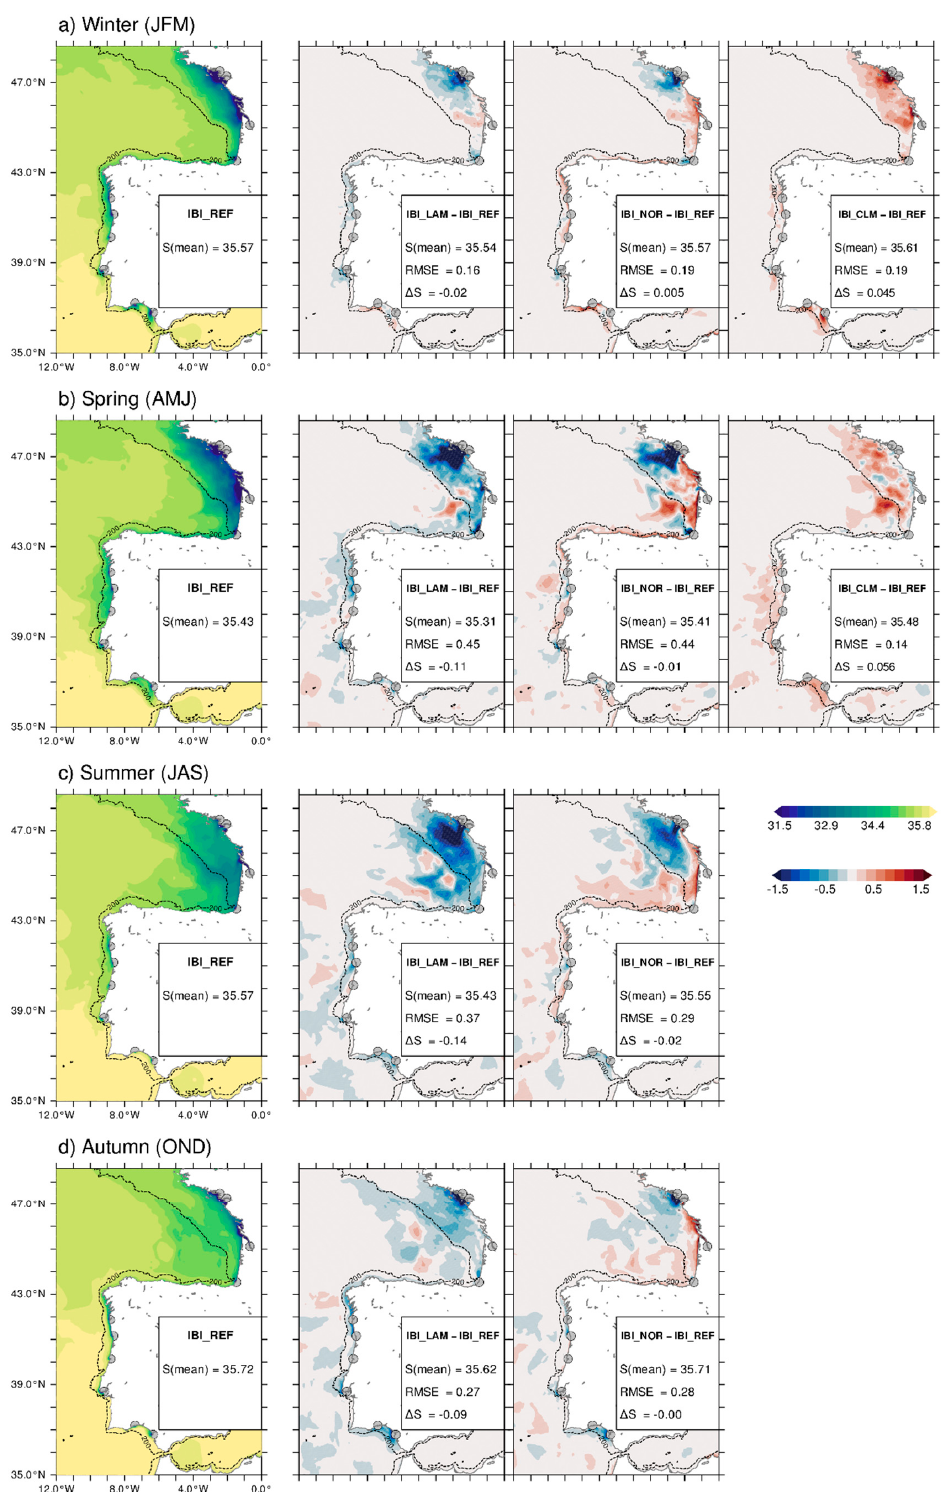
Figure 6. ( a ) Seasonal surface salinity in winter 2018 from IBI_REF (left panel) and difference of seasonal surface salinity between IBI_LAM, IBI_NOR, IBI_CLM (respectively in panels from left to right) and IBI_REF. ( b ) Same as ( a ) but in spring. ( c ) Same as ( a ) but in summer. ( d ) Same as ( a ) but in autumn. Red (blue) shading in the panels ( a ) to ( c ) means that the simulation is saltier (fresher) than IBI_REF. Salinity mean values and statistical metrics (root mean square error and bias computed when comparing each scenario with the reference one) are shown in each panel. Grey dots show the river mouth locations of the rivers considered in the IBI model